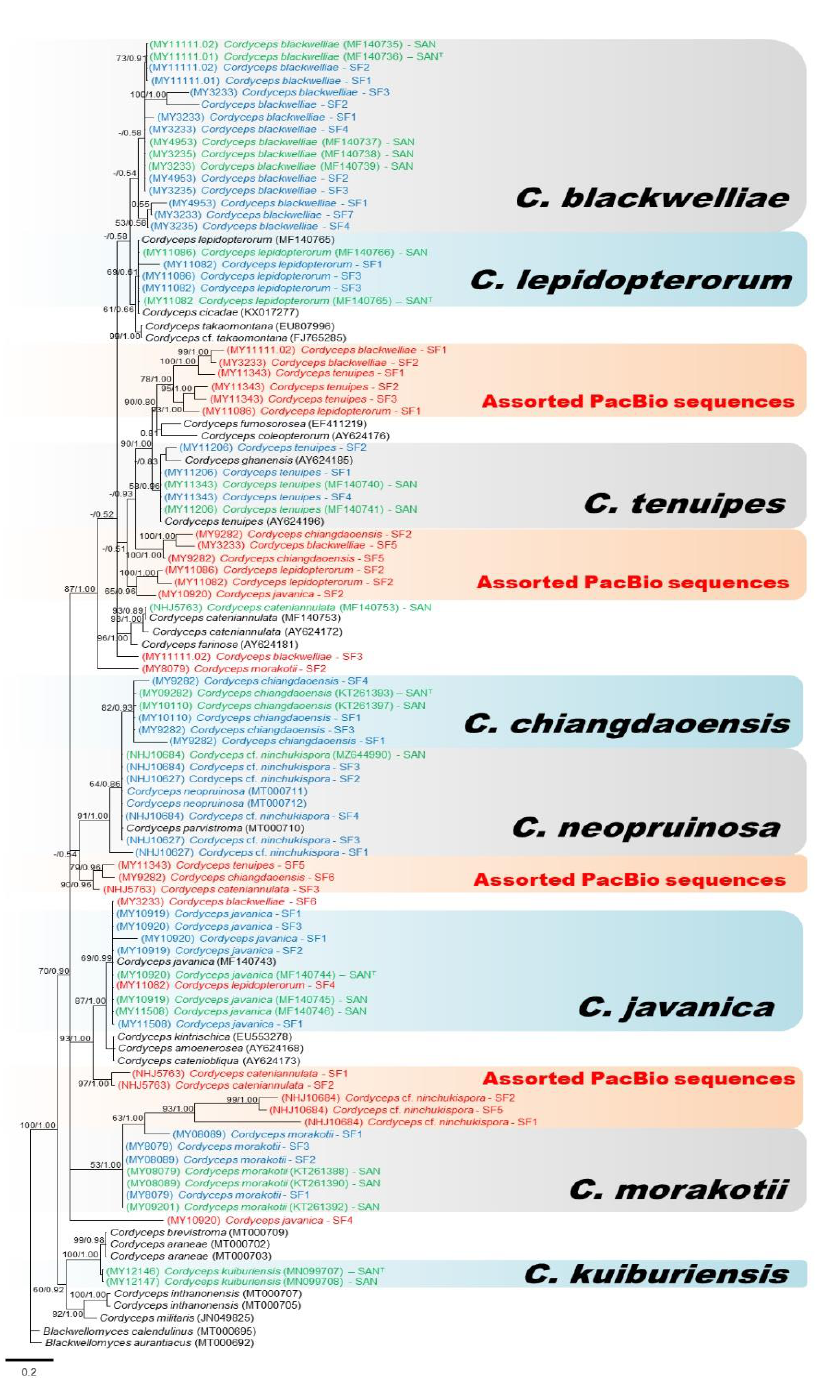
Figure A1. Consensus phylogram (50% majority rule) from a Bayesian analysis of the nrITS se- quences (obtained from SuperFi DNA polymerase), following an MCMC analysis of 10 6 generations. Maximum likelihood bootstrap values >50% (left of/) and Bayesian posterior probabilities >0.50 (to the right). The scale bar represents number of expected changes per site. Some PacBio cluster sequences are placed in blue (these cluster with similar species), others PacBio cluster sequences placed in red (variable PacBio cluster sequences, clustering with other species/strains). All Sanger sequences of studied strains are placed in green to highlight their phylogenetic position in the tree.